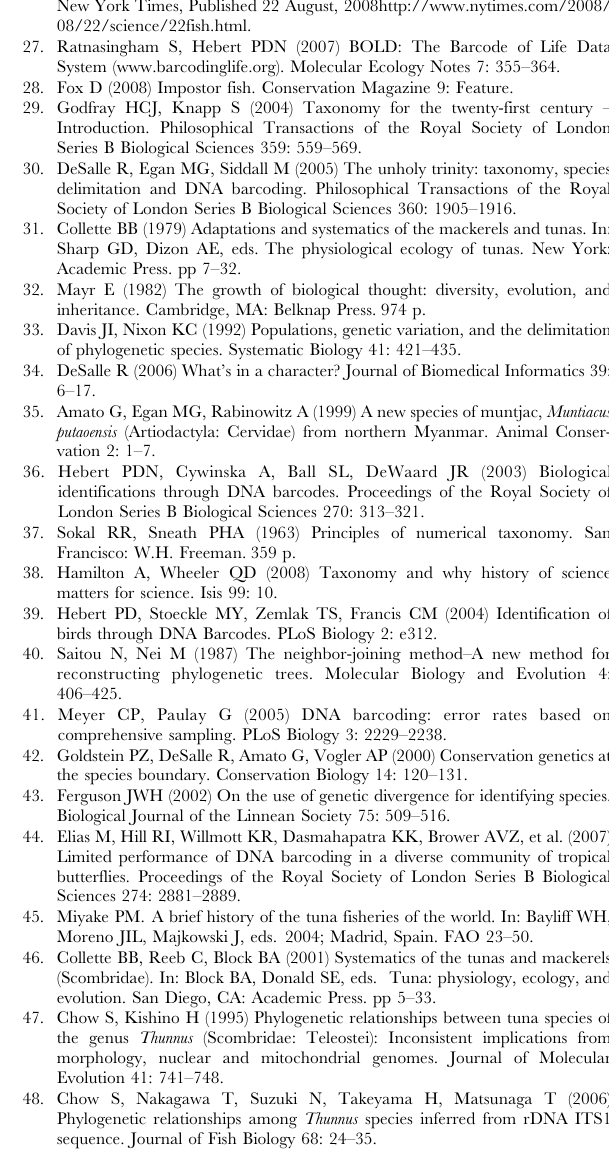
Figure S2 Neighbor-joining tree using the K2P substitution model built in BOLD-IDS using all publicly available Thunnus cox1 sequences. Note that yellowfin tuna ( T. albacares ) is